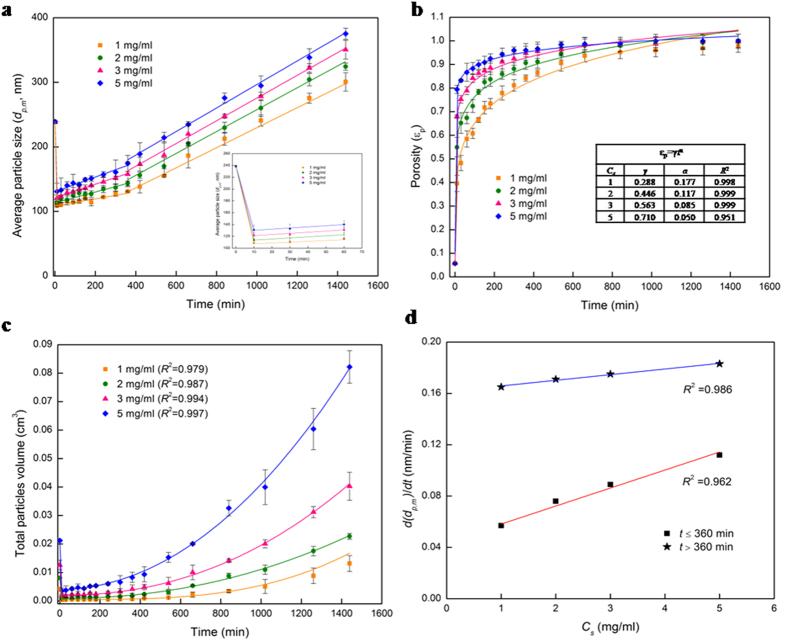
Surface and pore-scale reactive dissolution of xylan: porosity and swelling.(a–c) Temporal transformation of the physical properties of the solid substrate measured by Dynamic Light Scattering (DLS) techniques during the enzymatic hydrolysis of hemicellulose. Solid points are the experimental data and the solid lines are the best-fits. In (a) the change of average particle size indicates the initial rapid surface dissolution of the solid particles for 10 min (inset), followed by the swelling of the polymer particles for 11 h (i.e., the rest of the two-phase hydrolysis). In (b) 80–90% increase of porosity in the first 5 hours of hydrolysis suggests rapid pore-scale dissolution driven by the pore pressure drop. In (c) the degree of swelling of the polymers during hydrolysis is 2–4 for 1–5 mg/ml substrate loading. (d) The effect of the substrate loading on the d(dp,m)/dt (i.e., temporal rate of particle swelling) is a linear increase.